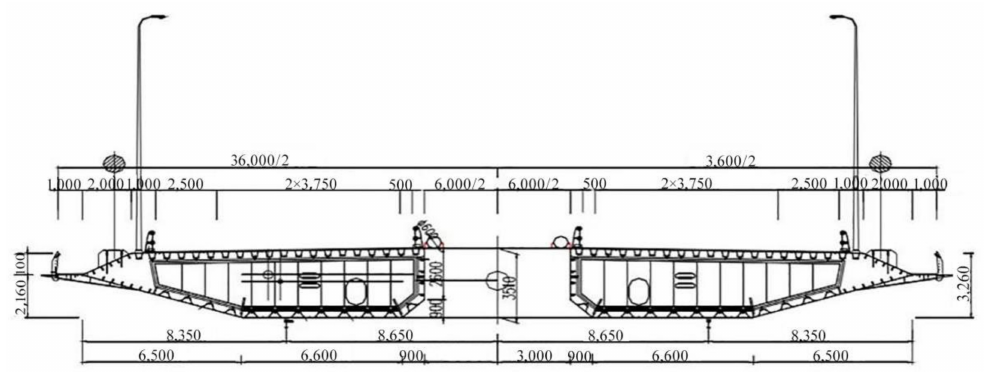
Figure 3. Relevant parameters of Xihoumen Bridge